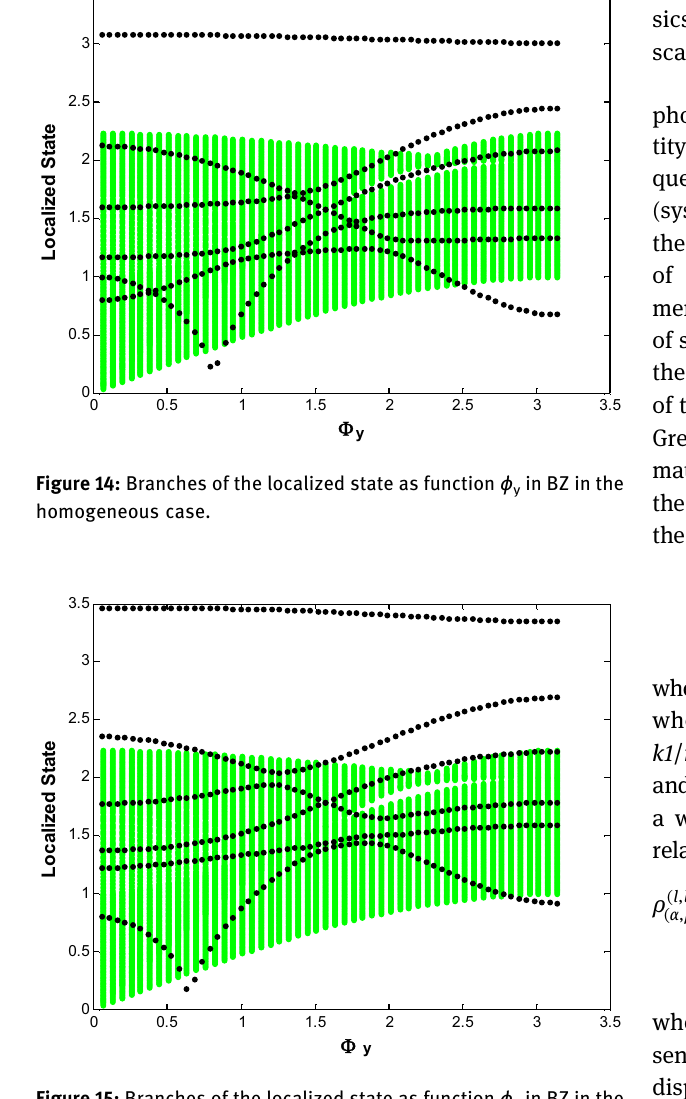
Figure 15: Branches of the localized state as function ϕ y in BZ in the hardening case.